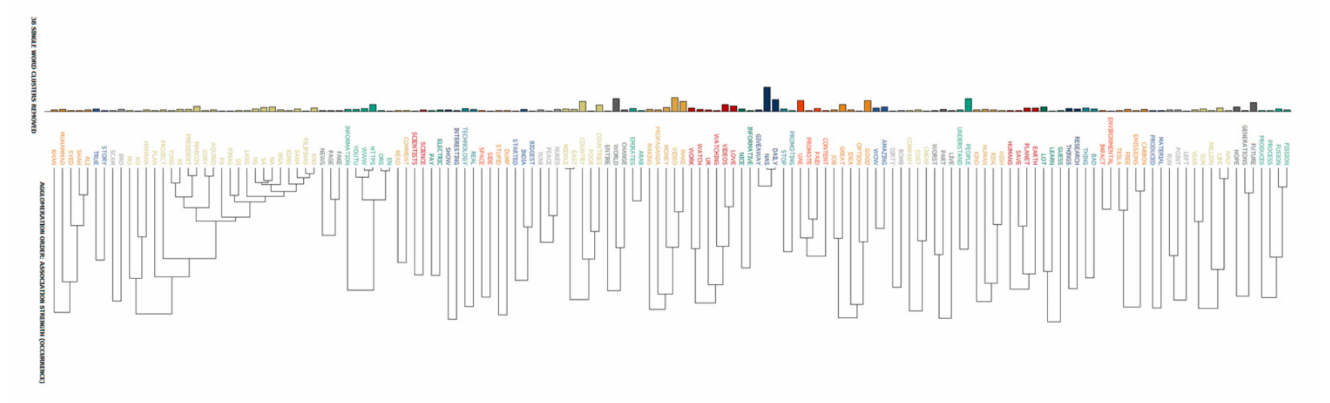
Figure A1. Hierarchical analysis applied to the comments on the ‘NAS daily’ post (dendrogram).